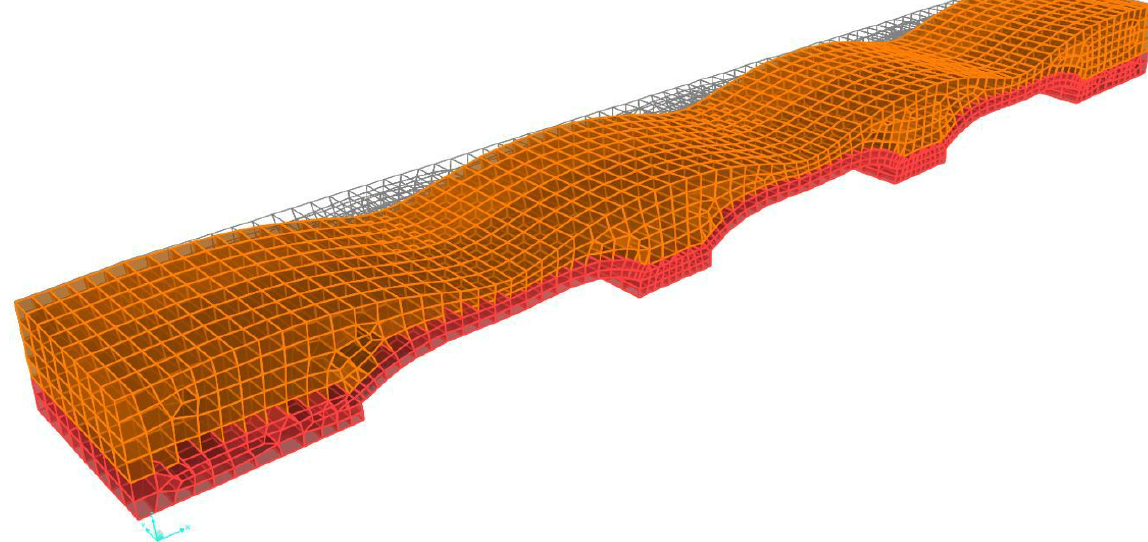
Figure 6: Porta Napoli bridge deformed shape.